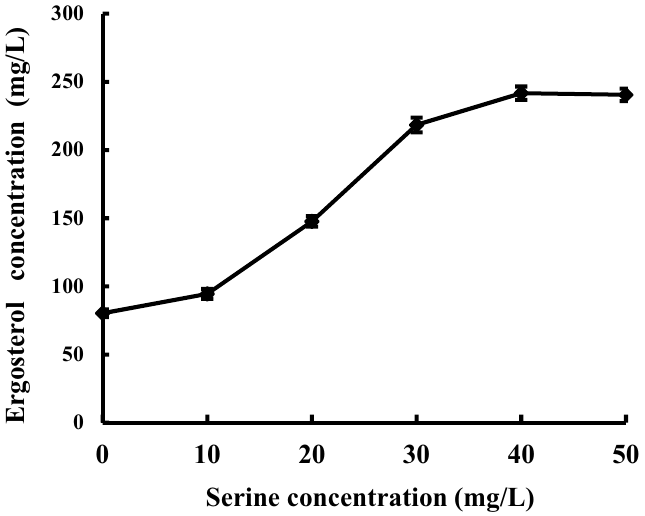
Figure 4. Effect of the serine concentration on the yield of extracellular